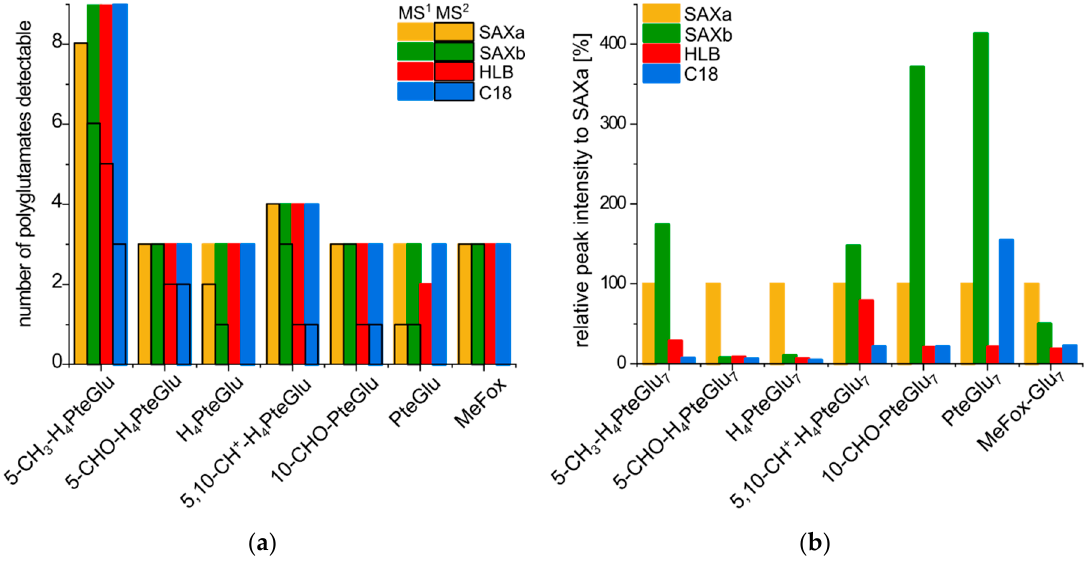
Figure 5. Qualitative analysis of the folate vitamers detectable in baker’s yeast samples purified by different solid phase extraction materials and measured with UHPLC-Q-ToF-MS with purification using SAXa: strong anion exchange (SAX) and elution with elution buffer; SAXb: SAX and elution with 20% acetonitrile and 5% formic acid; HLB: hydrophilic–lipophilic-balanced; C18: ( a ) number of detectable vitamers based on different vitamer groups at the MS 1 level (columns) and MS 2 level (black borders); ( b ) relative peak intensity for different heptaglutamates after normalization to SAXa.